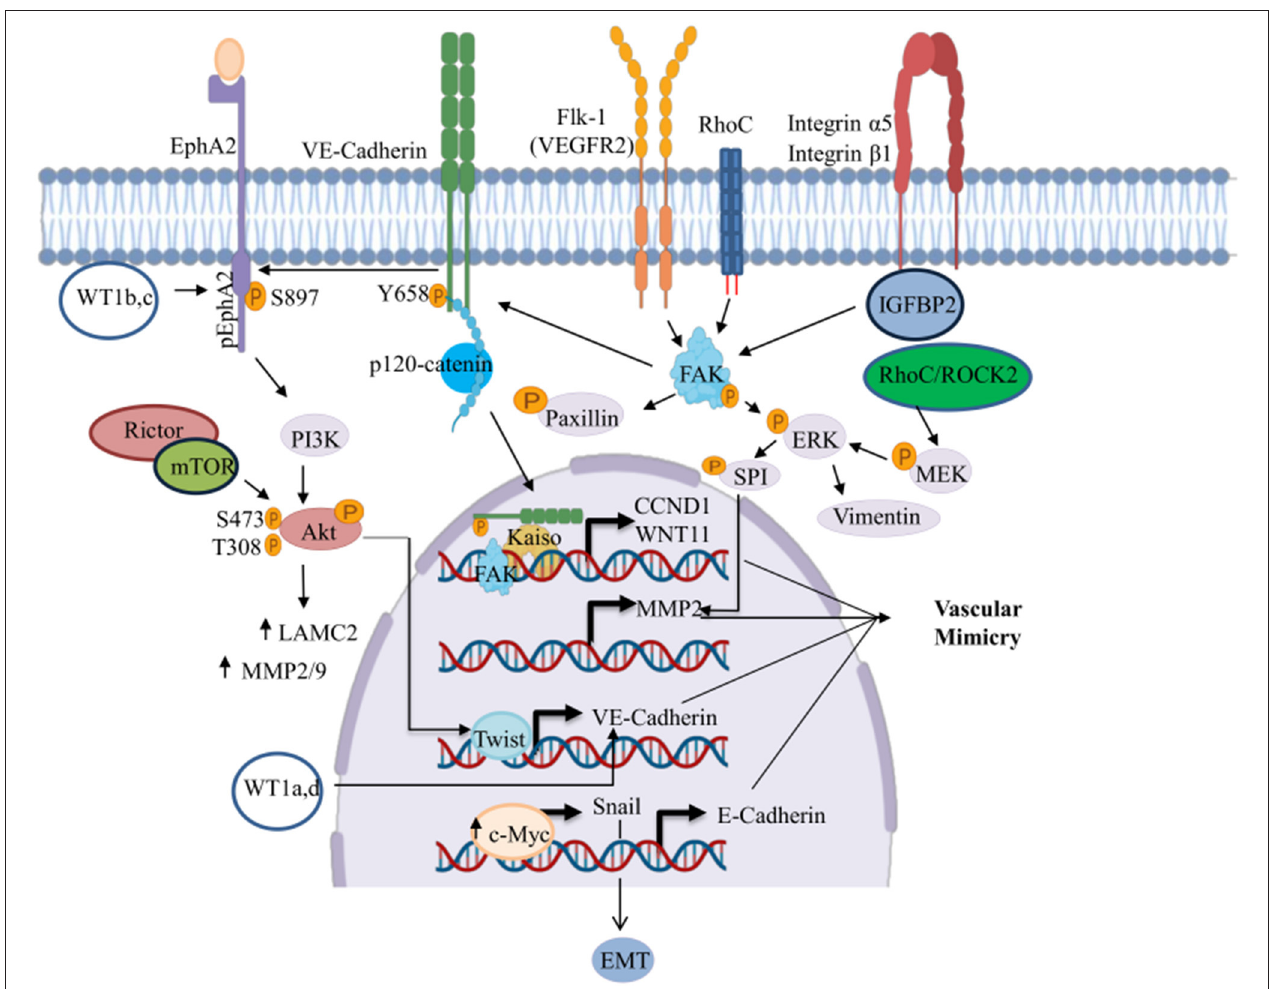
FIGURE 2 | Signaling pathways involved in the regulation of VM. This figure shows the signaling pathways triggering the transcriptional activation of genes involved in the development of VM. ↑ , Increased; , phosphorylated. Created with